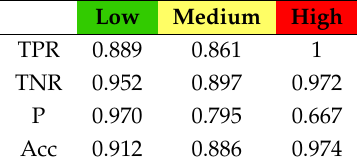
Table 9. Values of the metrics TPR, TNR, Precision and Accuracy for the Case Study.